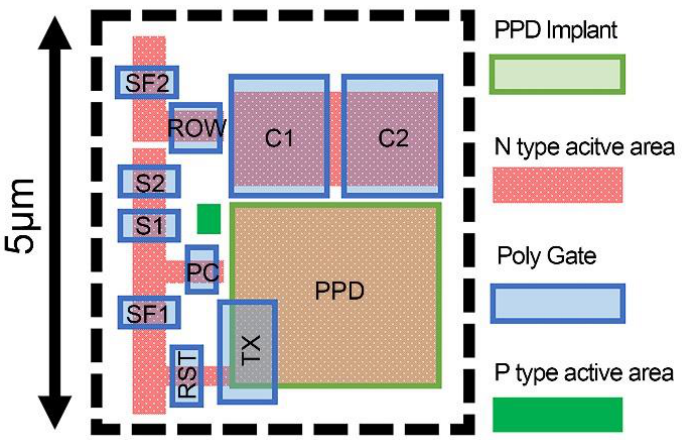
Figure 2. A typical cell schematic layout of an 8T GSI pixel.